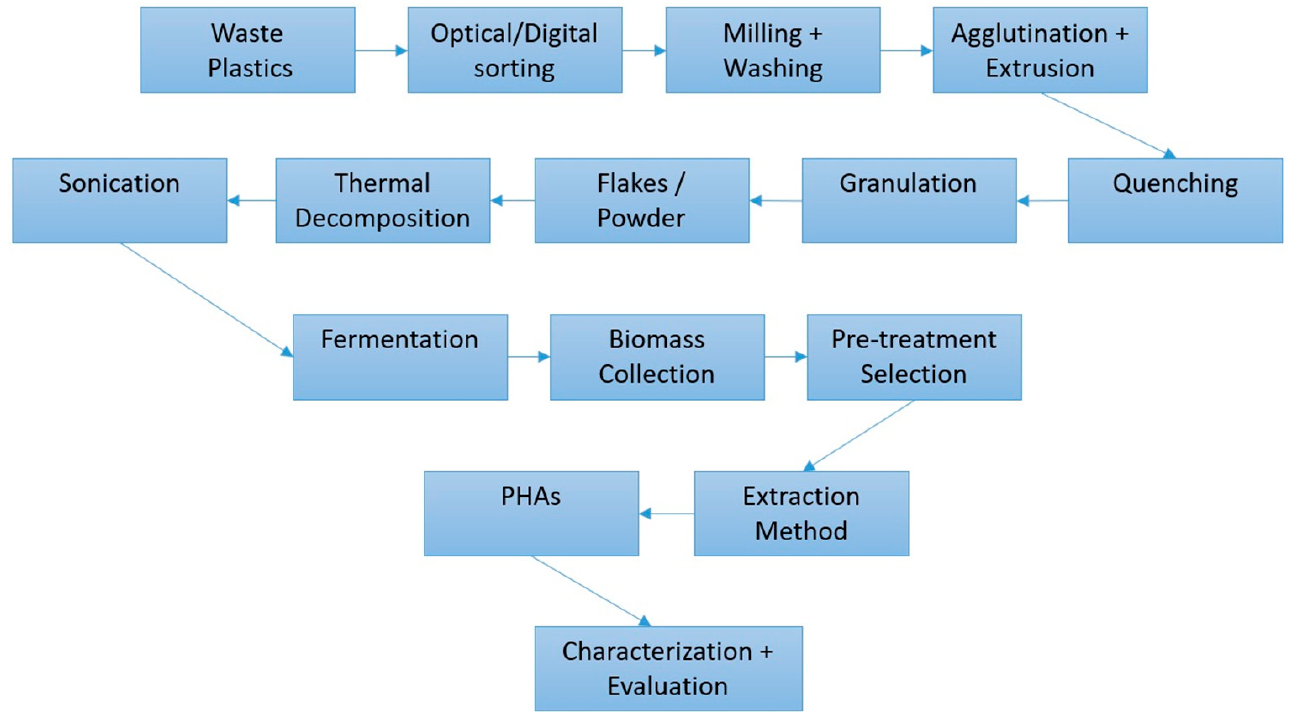
Figure 2. Potential operation stages for waste plastic material for the bio-generation of PHA bio- plastics, adapted from [3]. The ‘Pre-treatment Selection’ of ‘Biomass’ process could include methods such as ionic liquid soaking, sonication, glass sphere mixing, and blade/pressure homogenization. Every procedure such as this in today’s economy should end with an evaluation step to ascertain any shortcomings and potential investigation avenues.